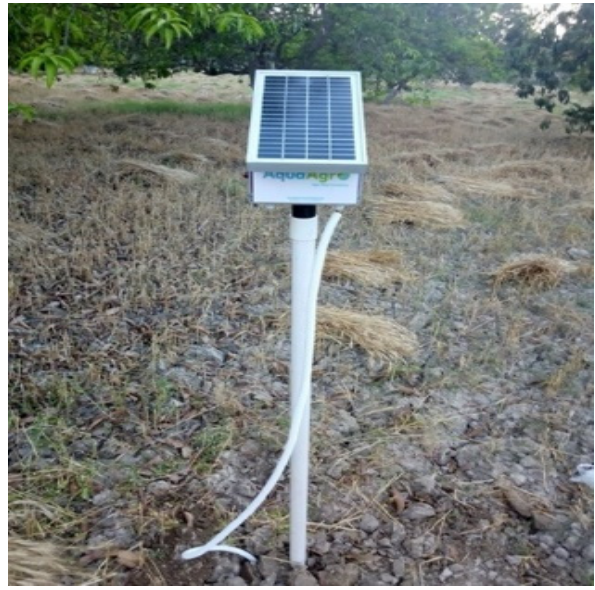
Figure 2. IoT device.